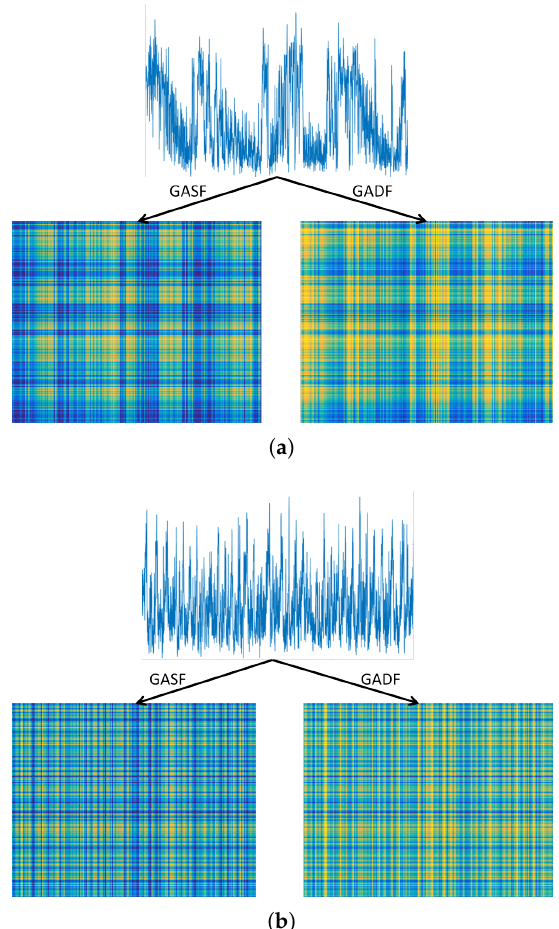
Figure 6. Gramian Angular Summation (GASF) and Gramian Angular Difference (GADF) mapping of ( a ) arcing and ( b ) data modulation.